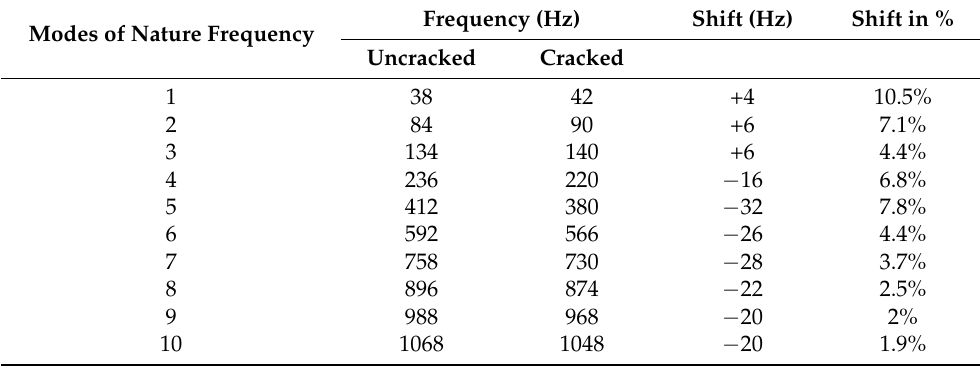
Table 2. Natural vibration frequencies of uncracked and cracked girders (un14-2 and cr14-2).